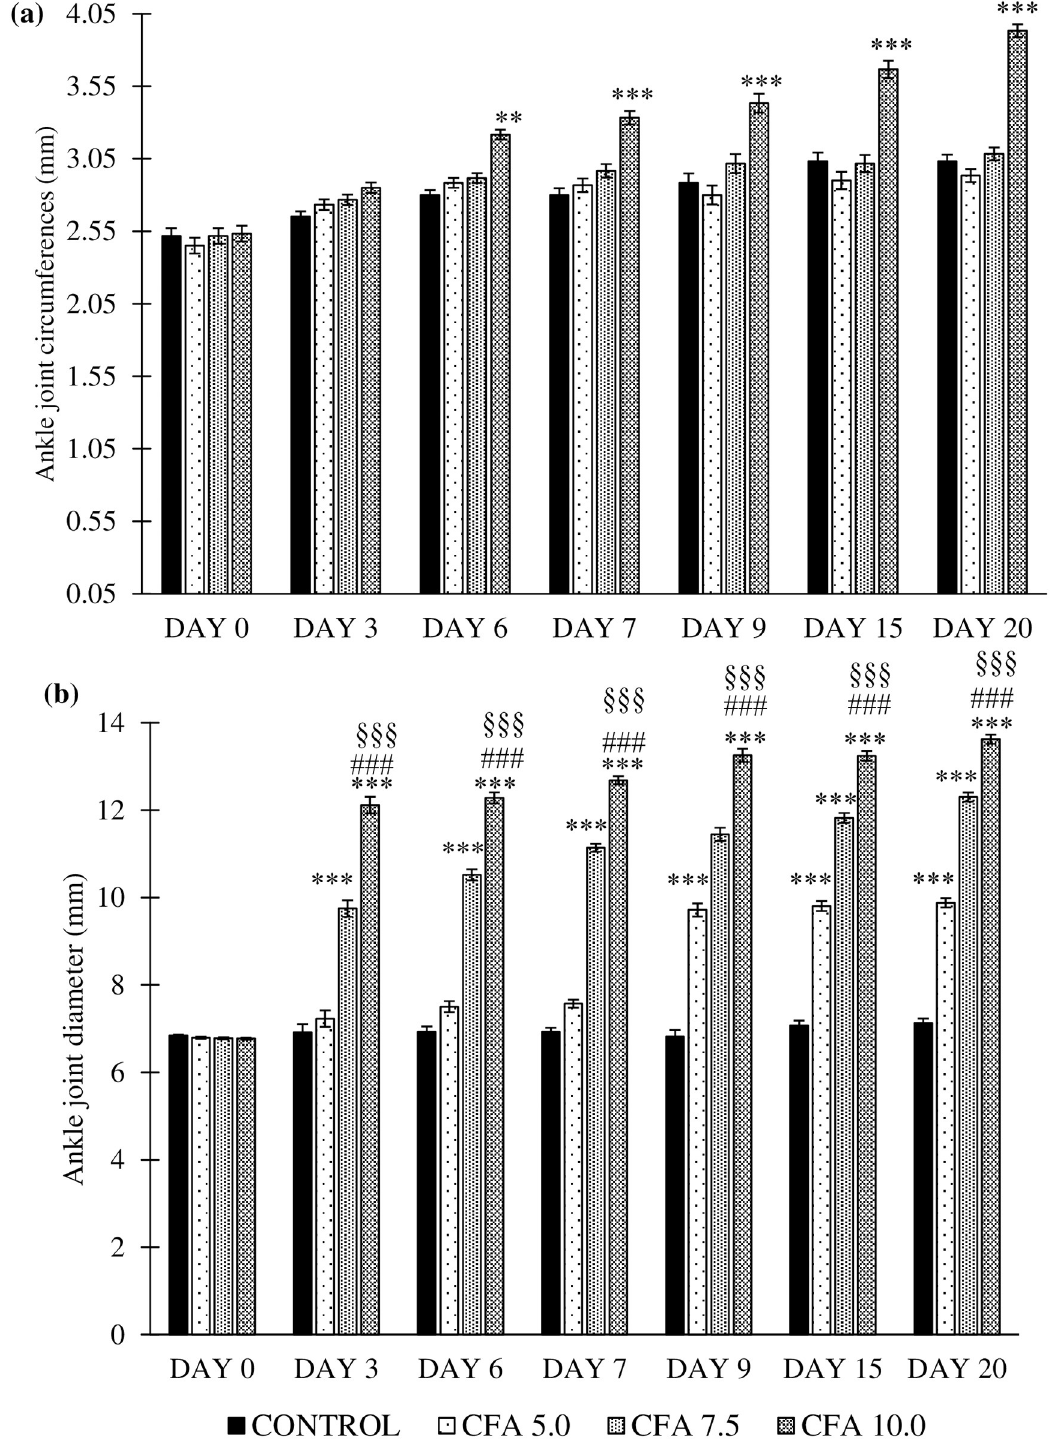
Fig 6. Changes in rats’ ankle joint (a) circumferences and (b) diameter at the ipsilateral (CFA-inoculated) hind paw in the treatment groups on day 0 to 20 (n = 6). The data are expressed as mean ± standard error of the mean (SEM). � p < 0.05 and �� p < 0.001 significant comparison to control group. ### p < 0.001 significant comparison to CFA 5.0 group and §§§ p < 0.001 significant comparison to CFA 7.5 group. CFA 10.0 group demonstrated the most reliable and constant gradual increase in the ankle joint oedema at the ipsilateral side compared to other doses of CFA inoculation.